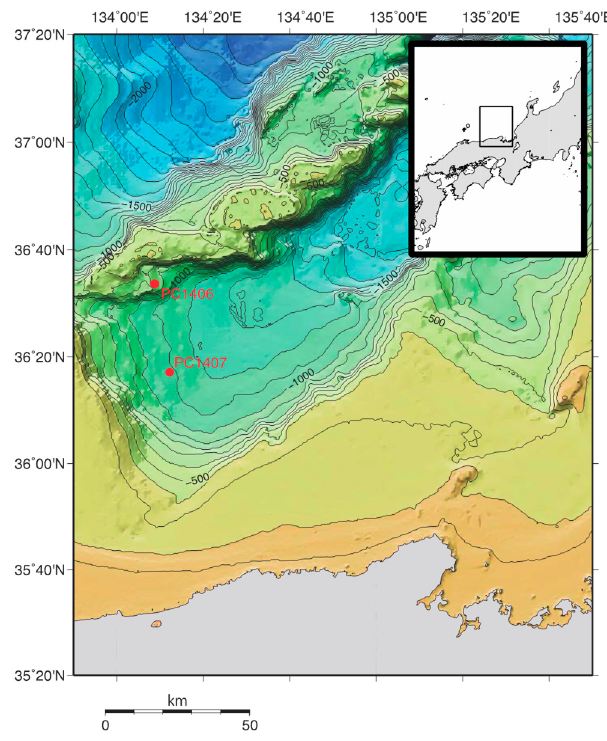
Figure 1. Location of the research area in the eastern margin of the Sea of Japan. Red dots show the location of piston core sampling sites PC1406 and PC1407 during the UM14-06